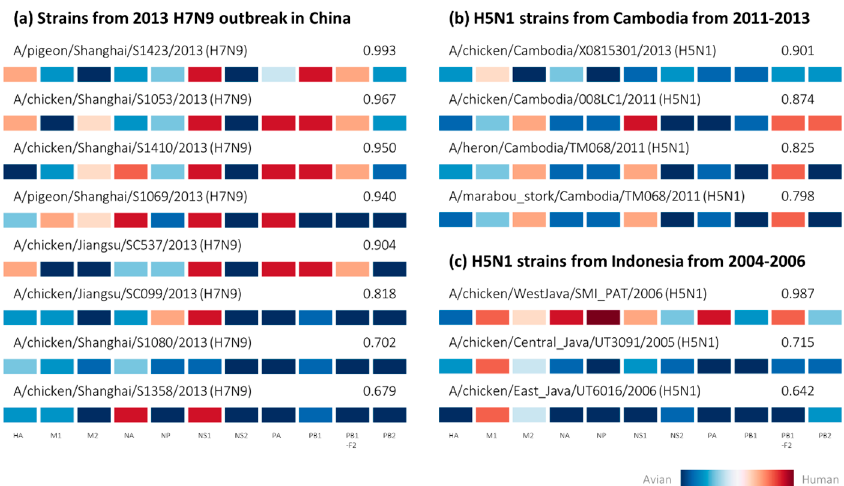
Figure 3. Avian-isolated strains from zoonotic influenza outbreaks represented by host tropism protein signatures with estimated zoonotic probability predicted by the zoonotic strain prediction model. The strains were cross-referenced with studies on phylogenetic analyses, demonstrating that some of these strains share high sequence similarities with zoonotic strains isolated from human patients during influenza outbreaks of ( a ) novel outbreak of H7N9 in China in 2013 and ( b ) H5N1 outbreaks in Cambodia from 2011 to 2013 as well as ( c ) Indonesia from 2004 to 2006.